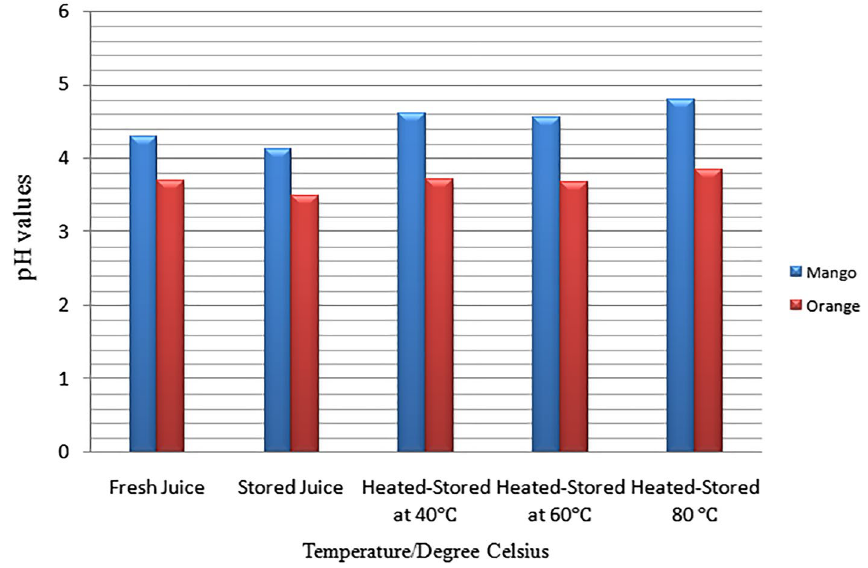
Figure 8. pH value of mango and orange juices.